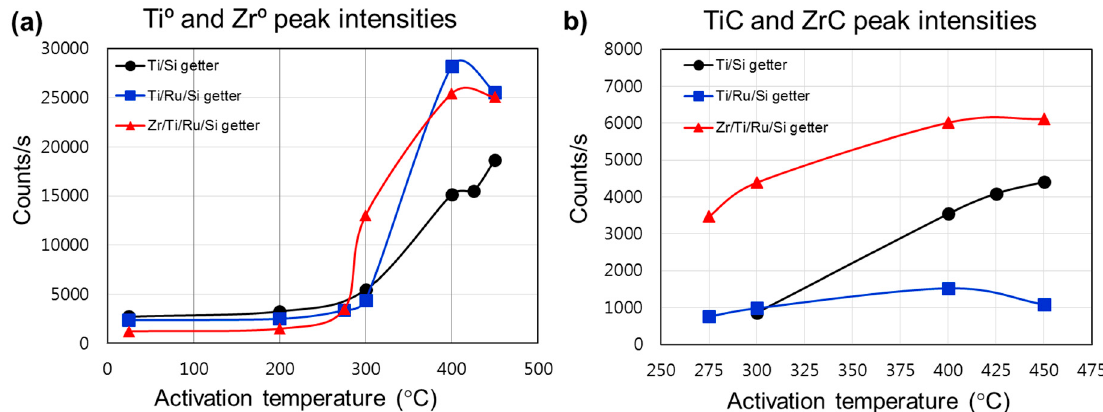
Figure 4. Plots of XPS elemental intensities as a function of activation temperature. ( a ) For Ti 0 and Zr 0 metallic states; ( b ) for TiC and ZrC carbide compounds.